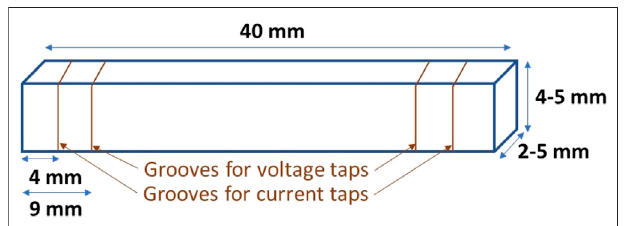
FIGURE 1 | Schematic of four probe conductivity